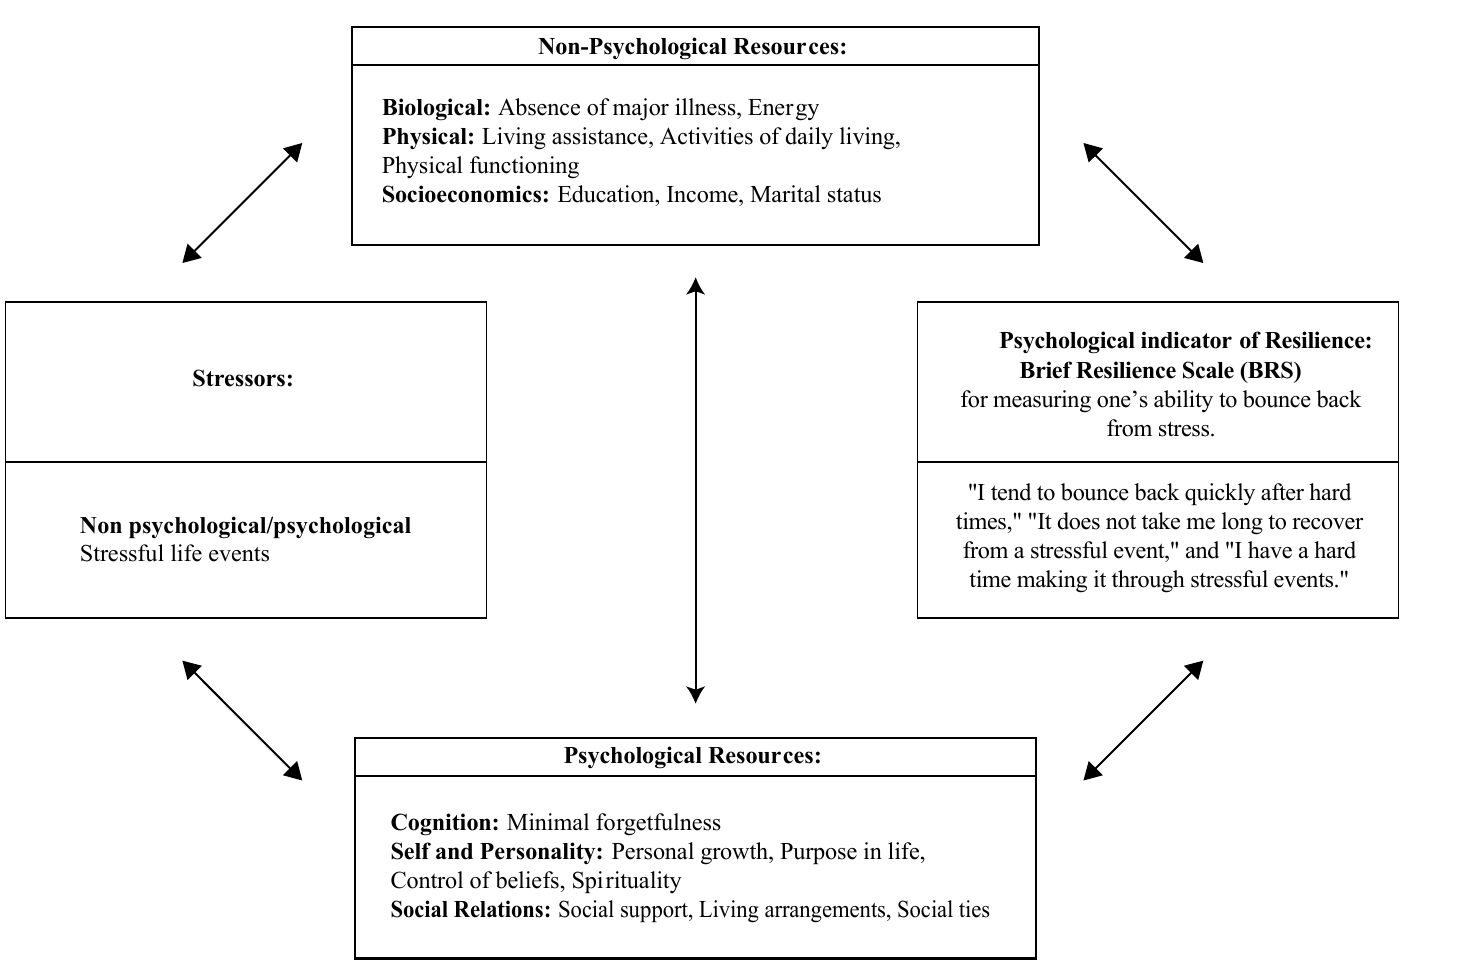
Figure 1. Stressors, resources (non-psychological and psychological), and self-reported psychological resilience [adapted from Staudinger’s theoretical model focused on resilience and aging (Staudinger et al. 2015)].